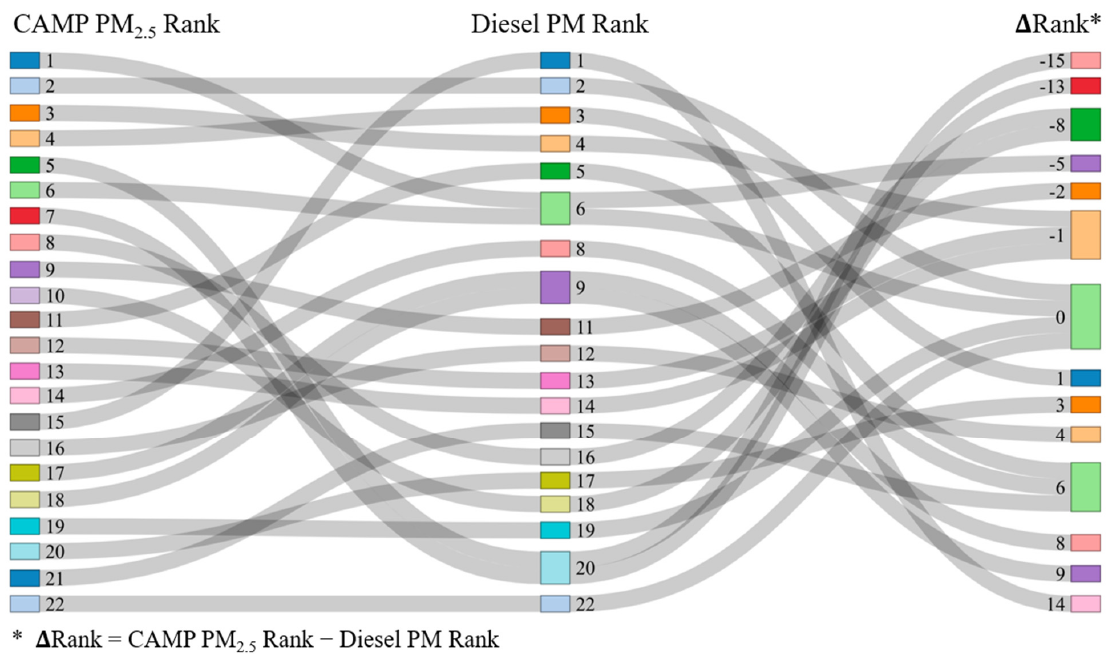
Figure 7. The rank difference between the CAMP PM 2.5 rank and the diesel PM rank of the 22 house- holds. Each line represents one household. Households ranking at the top were exposed to higher ambient PM 2.5 or diesel PM emissions; households ranking at the bottom were exposed to lower ambient PM 2.5 or diesel PM emissions.